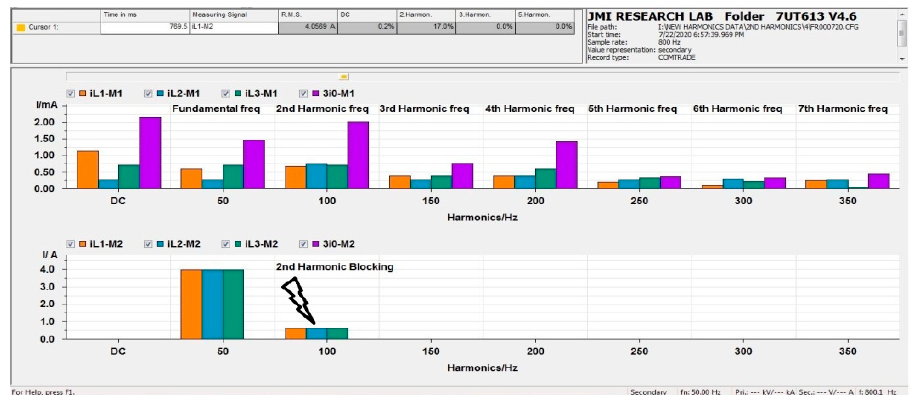
Figure 17. 2nd HB at 4000 mA Rated current & 15% of Inrush current condition.